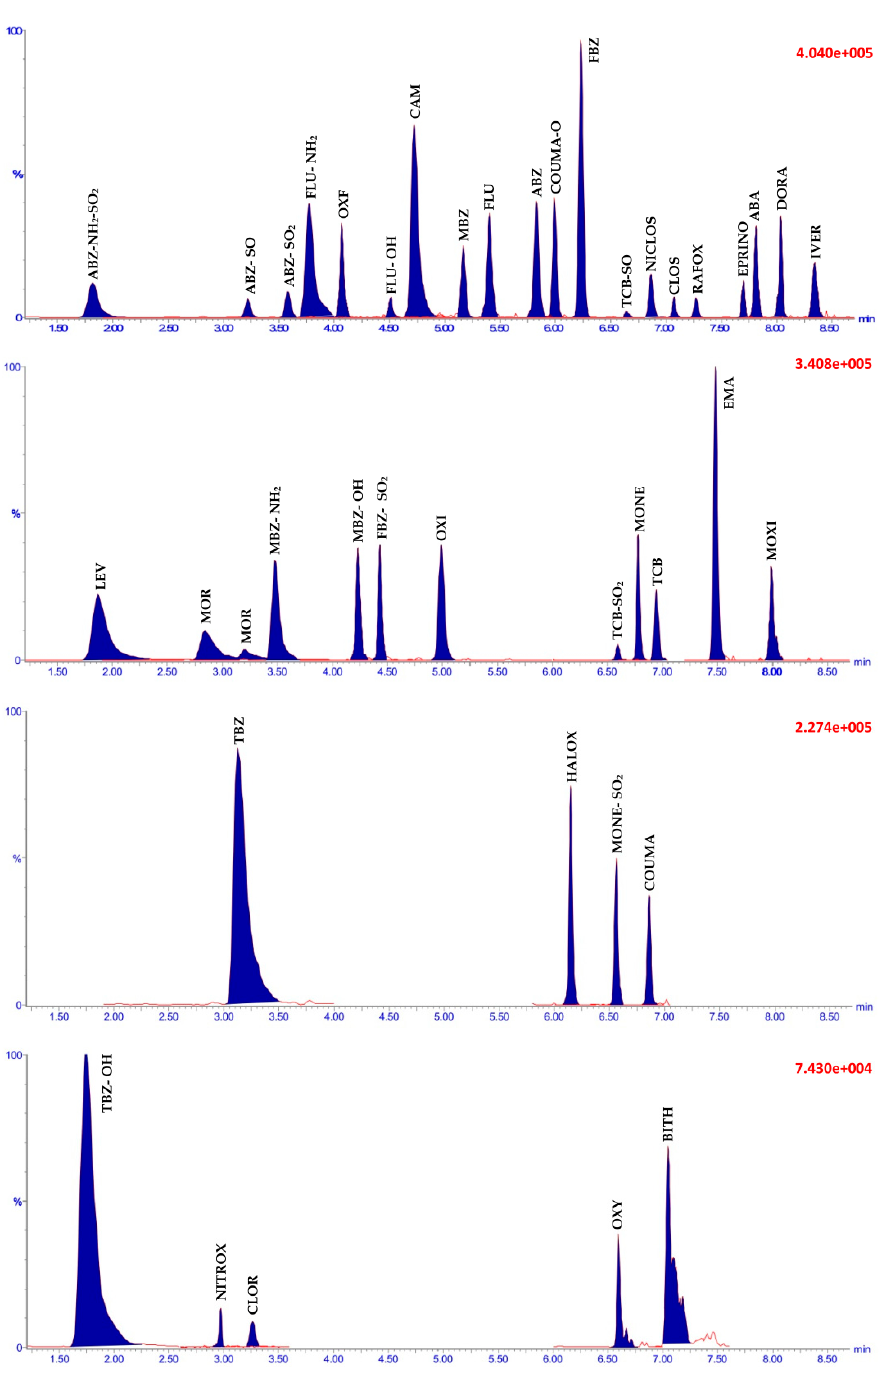
Figure 2. Overlay of LC-MS / MS chromatograms for the 40 anthelmintic residues in a blank water sample fortified at concentrations equivalent to the limit of quantification (LOQ) (see Table 2) for each analyte.